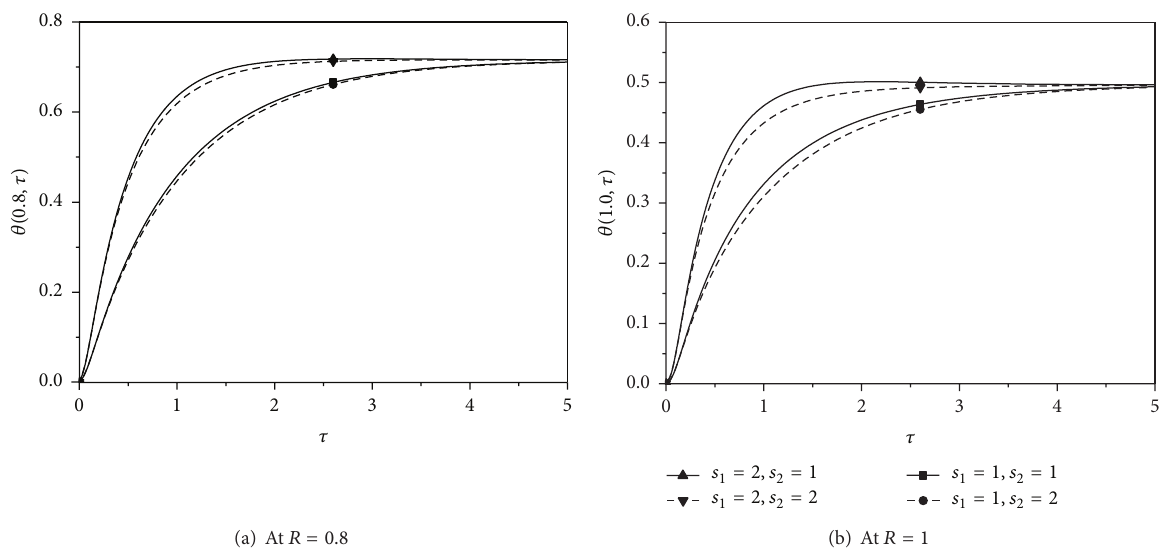
Figure 3: Influence of function parameters 𝑠 1 and 𝑠 2 on the temperatures of the hollow cylinder at middle and right surfaces, [ 𝜓(𝜏) = 1 −𝑒 −𝑠 1 𝜏 , Bi (𝜏) = 2 − 𝑒 −𝑠 2 𝜏 , 𝜃 0 = 0].